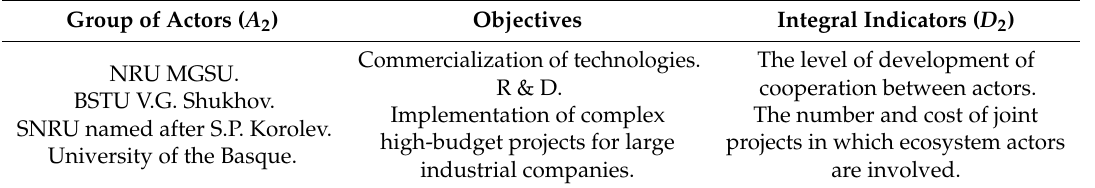
Table 3. Characteristics of actors—partners of the ecosystem.